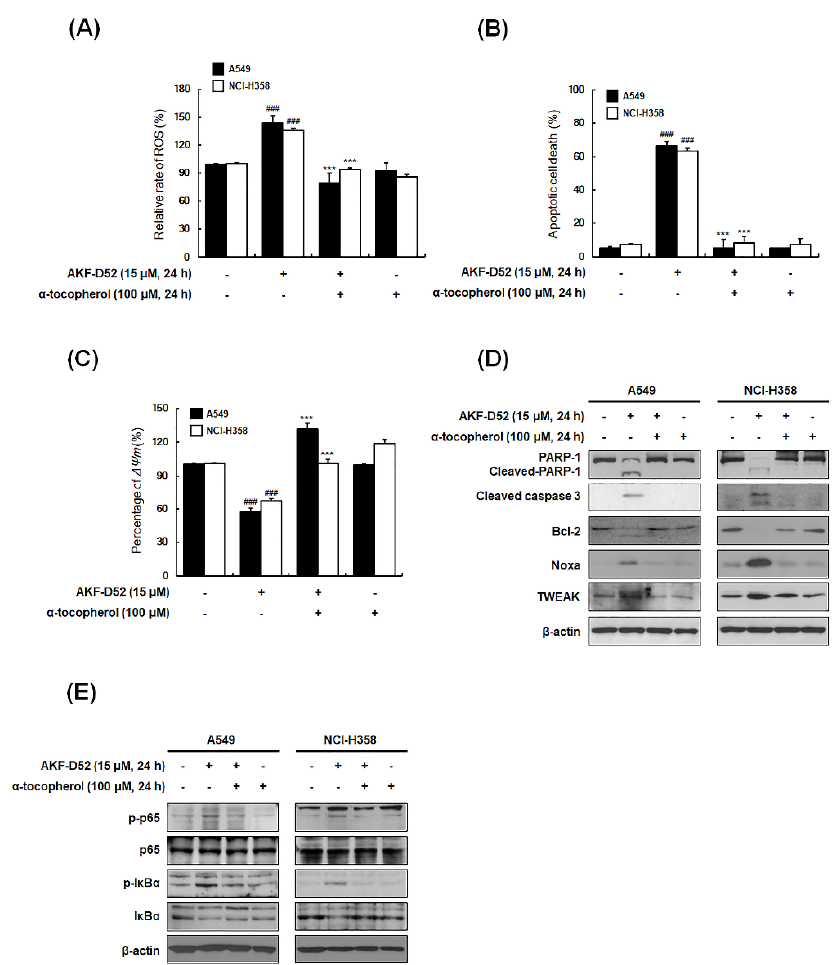
Figure 6. The effects of AKF-D52 on activation of ROS signaling pathways in NSCLC cells. ( A ) Cells were pre-treated with α -tocopherol (an ROS scavenger) for 1 h and then treated with AKF-D52 for 2